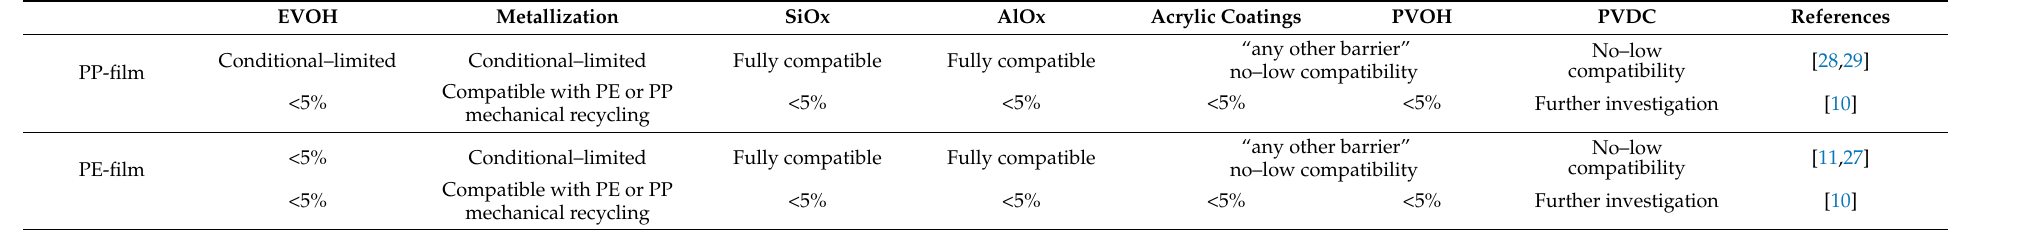
Table 3. Tolerated materials in multilayer barrier flexible packaging modified after the works in